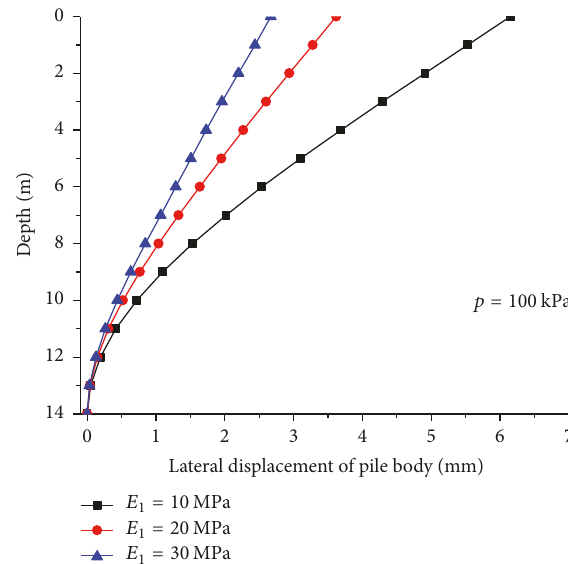
Figure 6: Relationship between lateral displacement of pile and 𝐸 1 .